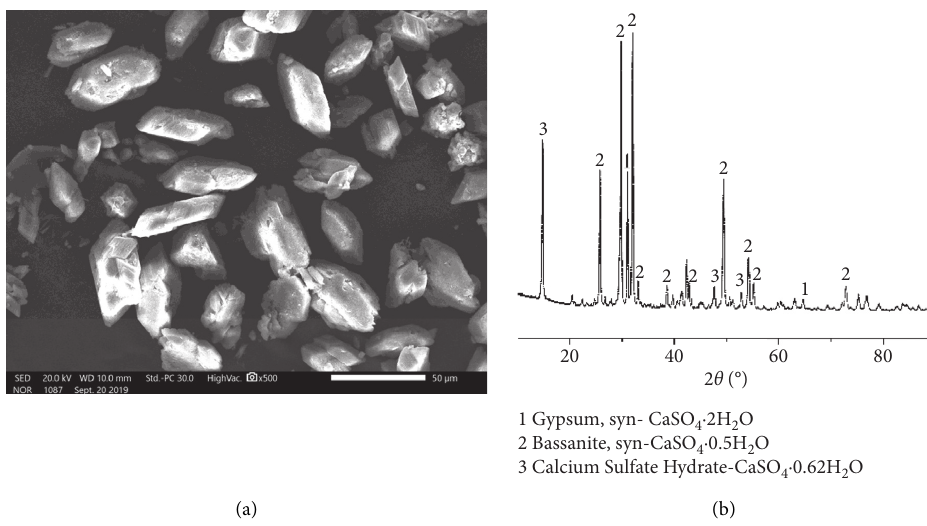
Figure 2: SEM and XRD analyses of desulfurization gypsum. (a) SEM image × 500. (b) XRD